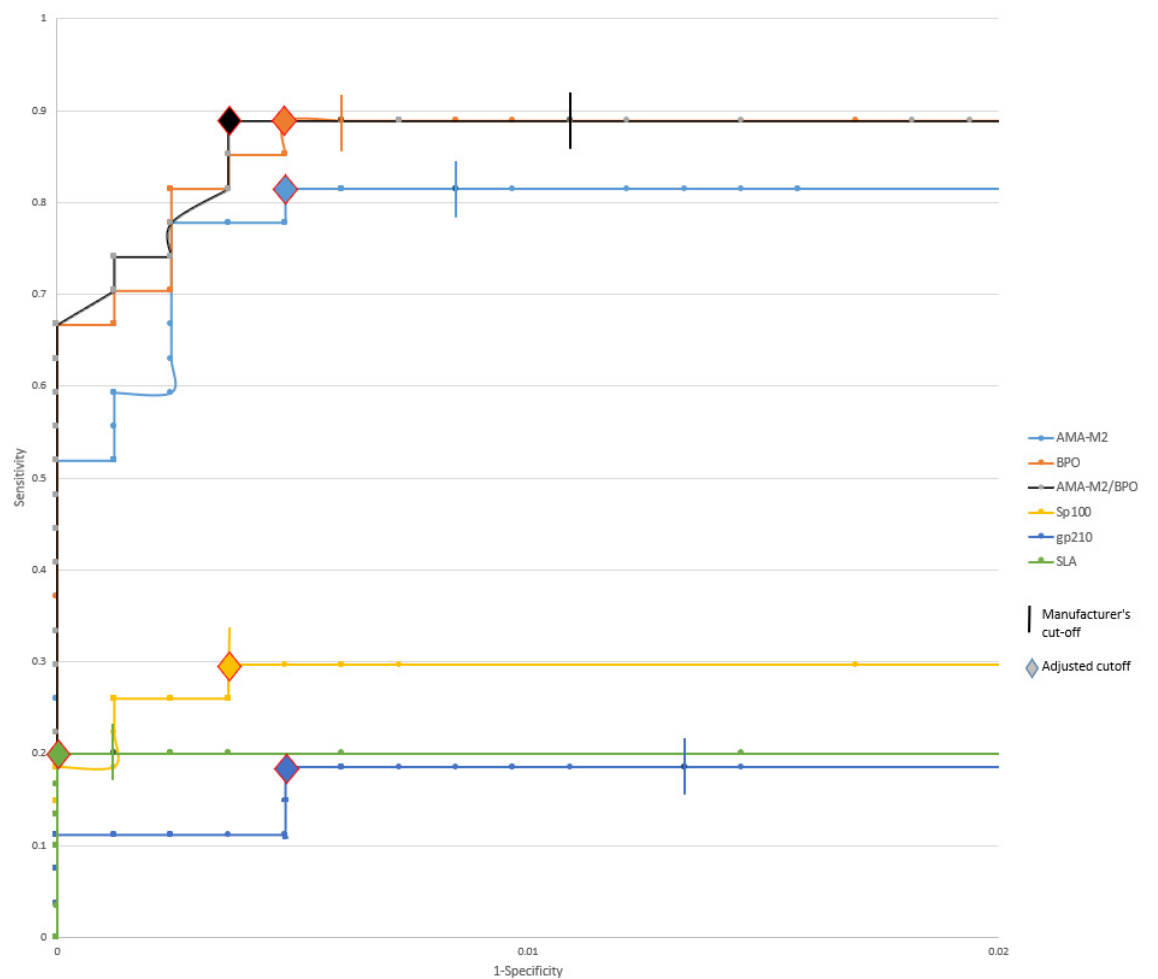
Figure 4. ROC curve for each specificity with EUROLINE’s recommended cut-off (>10) with truncated X-axis. AMA-M2—E2 subunit of pyruvate dehydrogenase; BPO—recombinant fusion protein of the E2-subunits of the three main M2-antigens branched-chain 2-oxoacid dehydroge- nase complex [BCOADC], pyruvate dehydrogenase complex [PDC] and 2-oxoglutarate dehydro- genase complex [OGDC]); AMA-M2/BPO—AMA-M2 and/or BPO; Sp100—speckled protein 100; gp210—glycoprotein 210; SLA—soluble liver